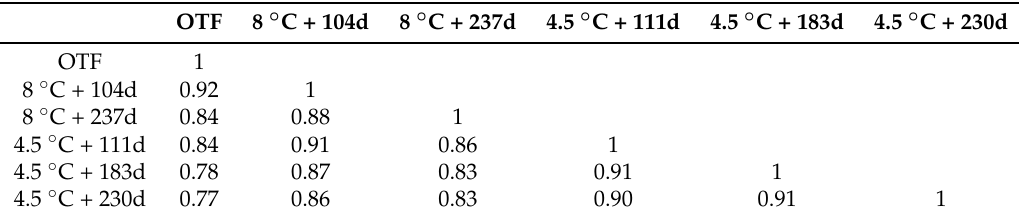
Table 1. Correlation of fry color between storage treatments. Pearson correlation coefficients comparing fry color of the tubers harvested in 2015 ( n = 274) stored under different conditions and lengths of time (shown as days post-harvest).